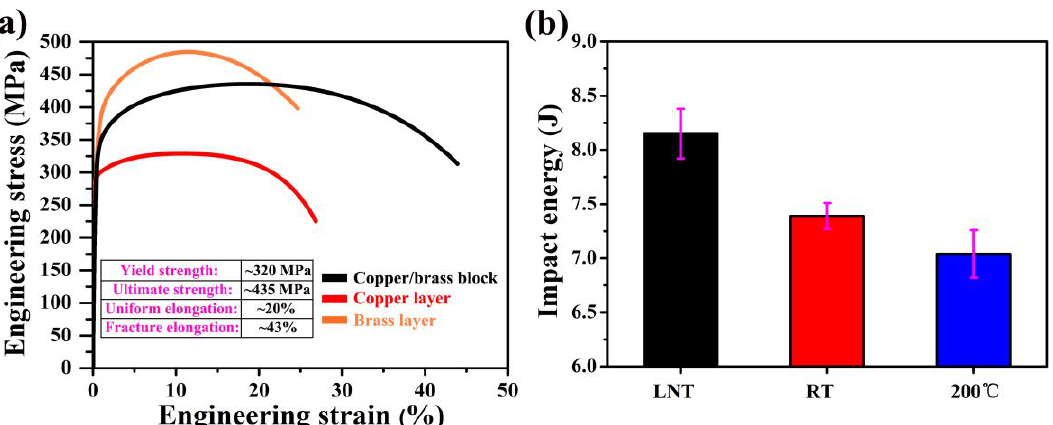
Figure 5. ( a ) The engineering stress – strain curves of the copper layer, brass layer, and multilayered soft – hard copper – brass block. ( b ) The impact energies of the present multilayered soft – hard copper – brass block tested at various temperatures.